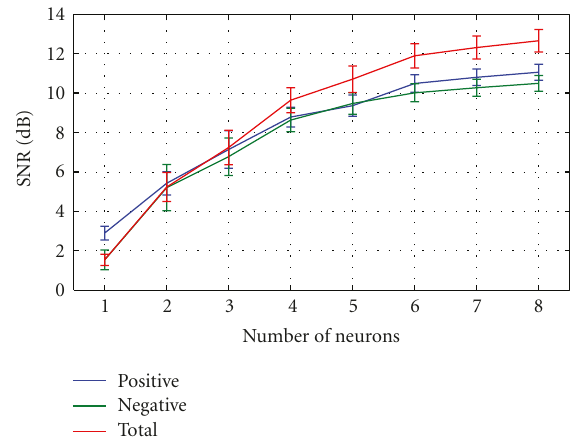
Figure 8: SNR for the positive (blue), negative (green), and total stimulus (red) as a function of the number of encoding